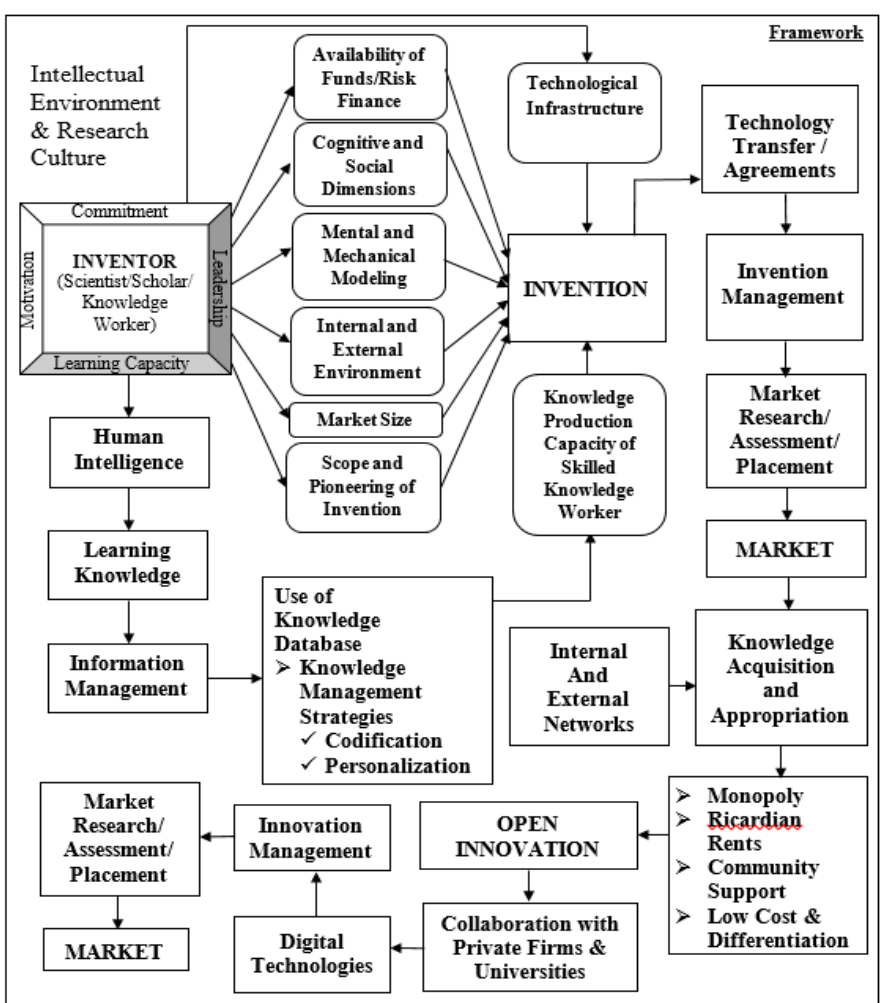
Figure 1. Conceptual Model of Invention and Open Innovation Processes & Linkages.